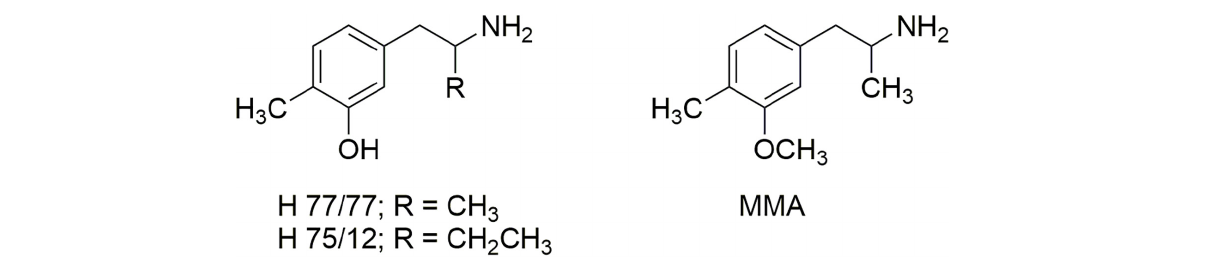
FIGURE 4 | The structures of 4, α -dimethyl-meta-tyramine (H 77/77) and 4-methyl- α -ethyl-meta-tyramine (H 75/12) and 3-methoxy-4-methylamphetamine